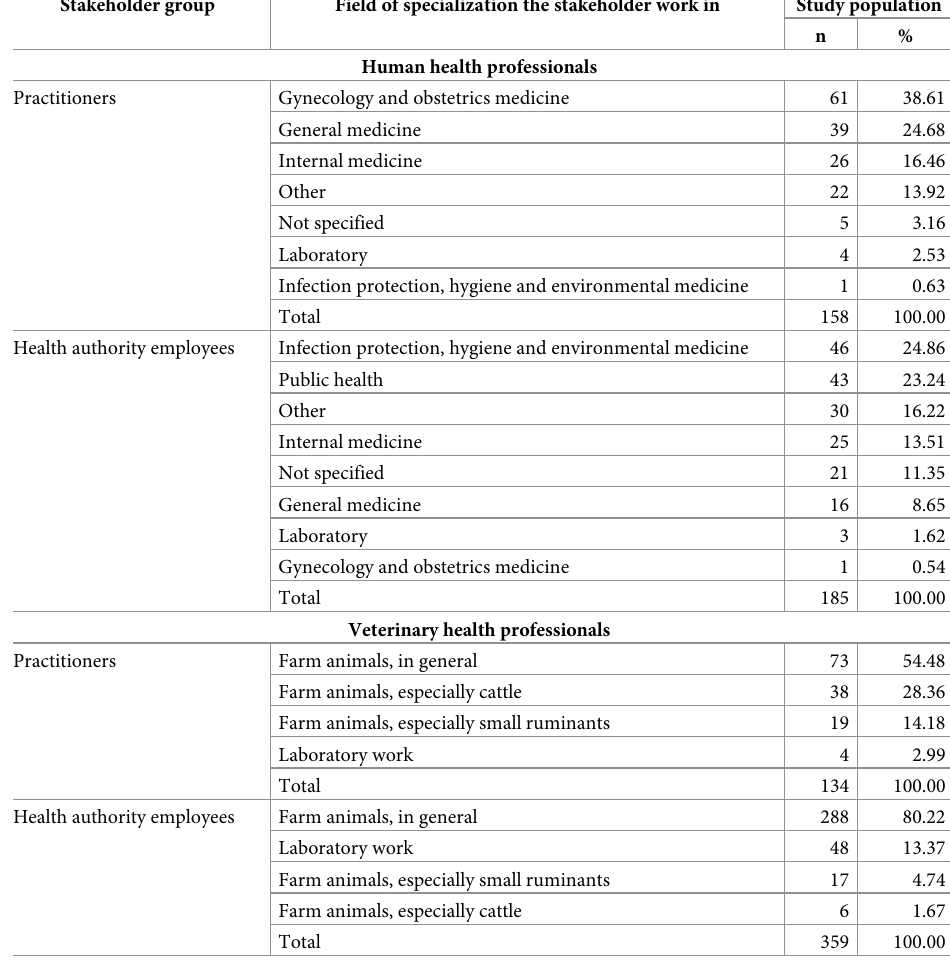
Table 1. Description of human and veterinary health professionals of Germany based on the field of specialization (online